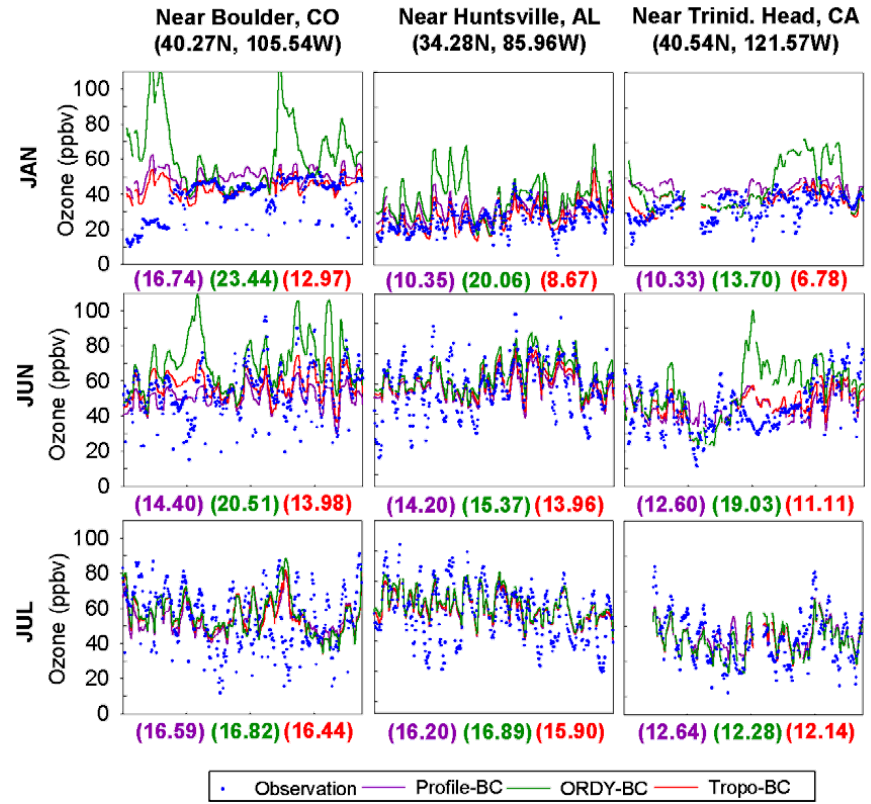
Fig. 11. Comparison of simulated and measured surface ozone concentration for month of January, June and July from the selected sites. The quoted value at the bottom of each plot revives the root mean square error of each case.